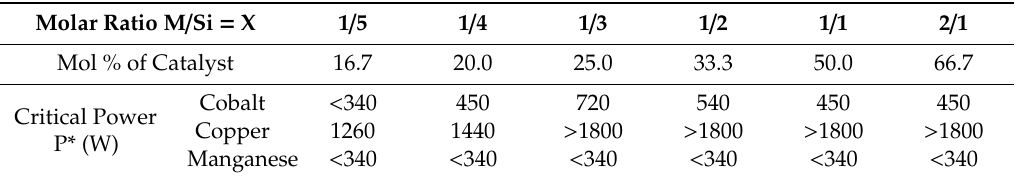
Table 3. Critical microwave power (P*) as a function of molar ratio of Catalyst / Silica support for Co, Cu and